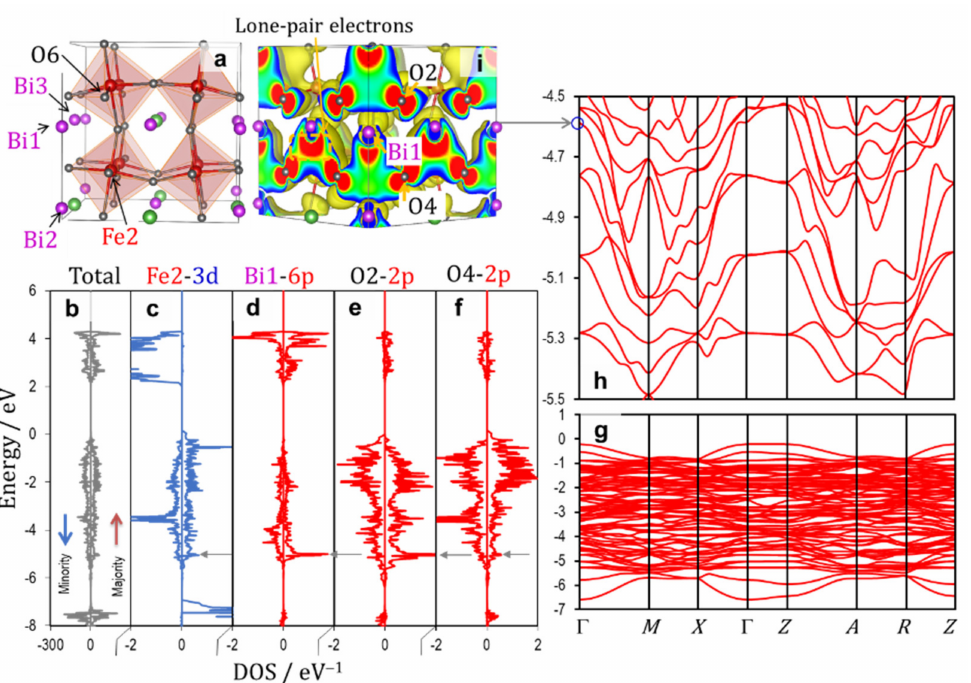
Figure 6. Crystal structure ( a ), electronic density of states (DOS) ( b – f ), band structures (of the majority spin band) in the valence band ( g , h ), and i wavefunction of the band shown in the blue circle of the tetragonal cell ( x = 3/8). The up (red) and down (blue) arrows in ( b ) denote the majority and minority spin bands, respectively. The horizontal arrows (gray) in ( c – g ) correspond to the energy level of the blue circle in ( h